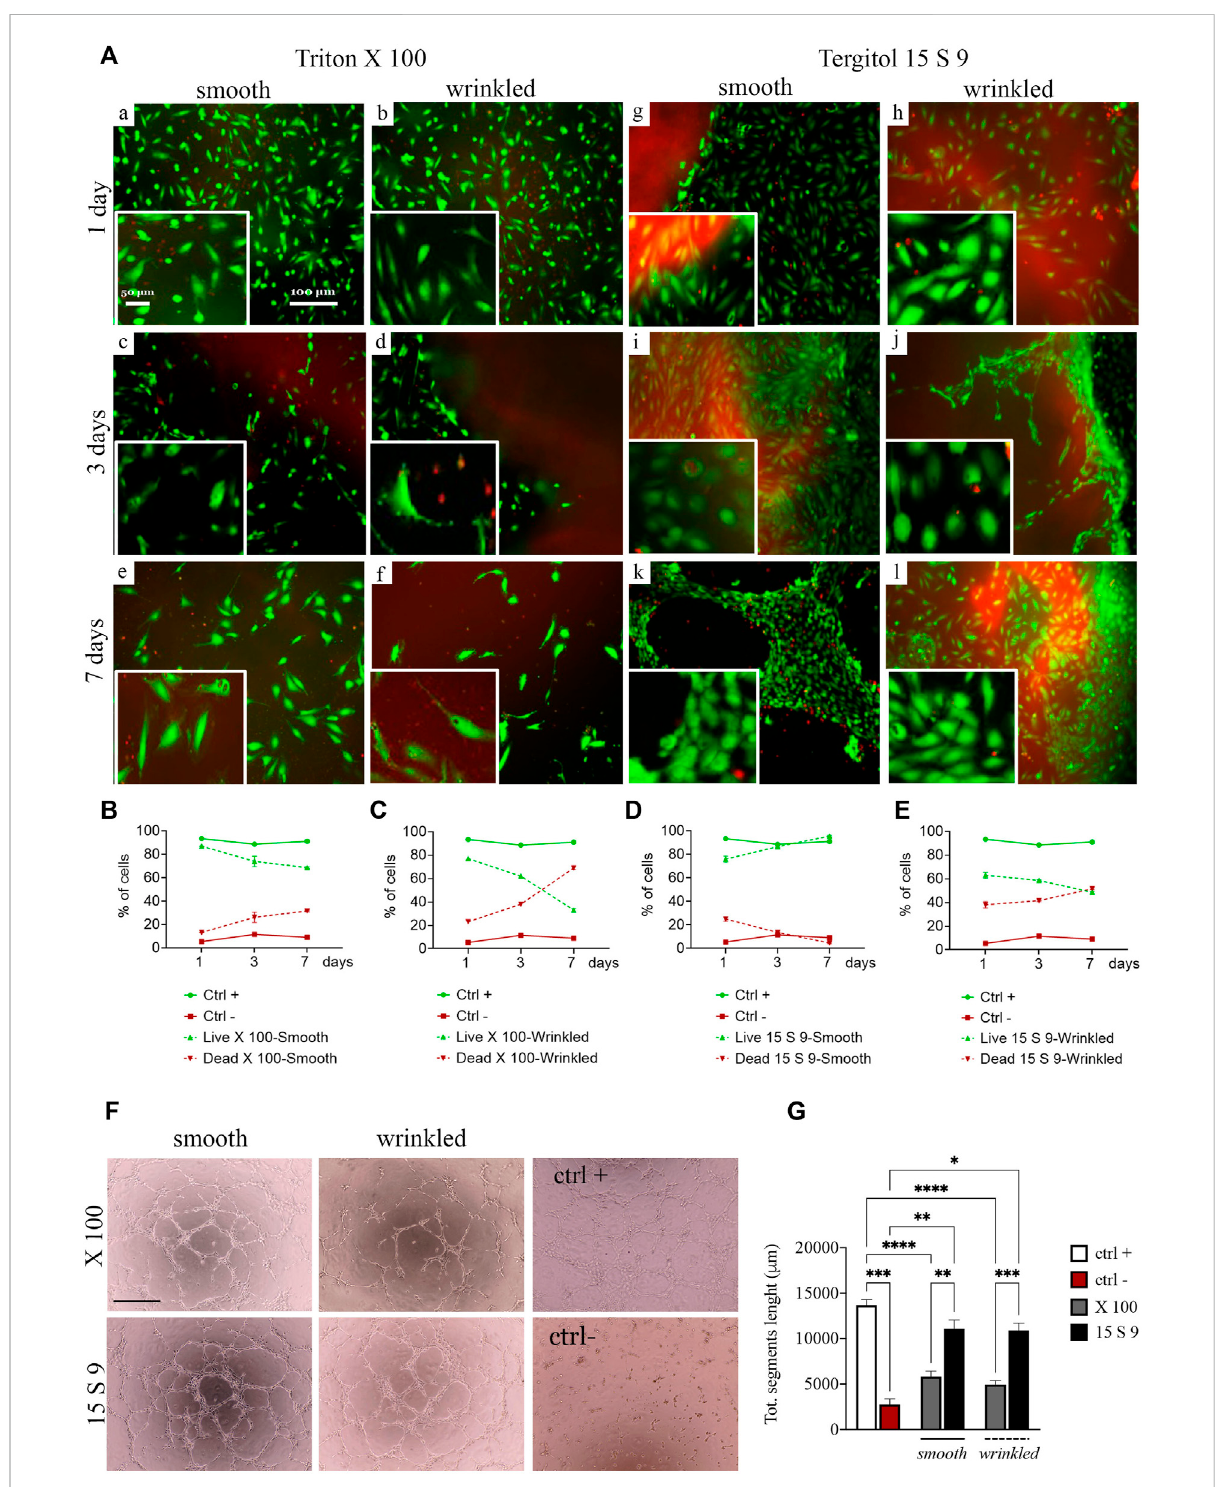
FIGURE 5 Cytocompatibility and angiogenic capacity retained after treatments. (A) Live/dead staining and quanti fi cation of SIS dECM. A decrease in viability from day 2 was observed in smooth (a, c, e) and wrinkled (b, d, f) tissue treated with X100 for all timepoints (1, 3, and 7 days). This is demonstrated by the quanti fi cation of HUVEC cell viability/mortality at different times (B) . In the wrinkled X100, mortality increased to a greater extent, starting from day2, and more rapidly, as presented in thegraph (C) . At no time did theHUVECs reach completematuration and viability. In contrast, the cells of the 15 S 9 tissue found an excellent microenvironment. In fact, after 7 days, the HUVECs in the smooth tissue alone had